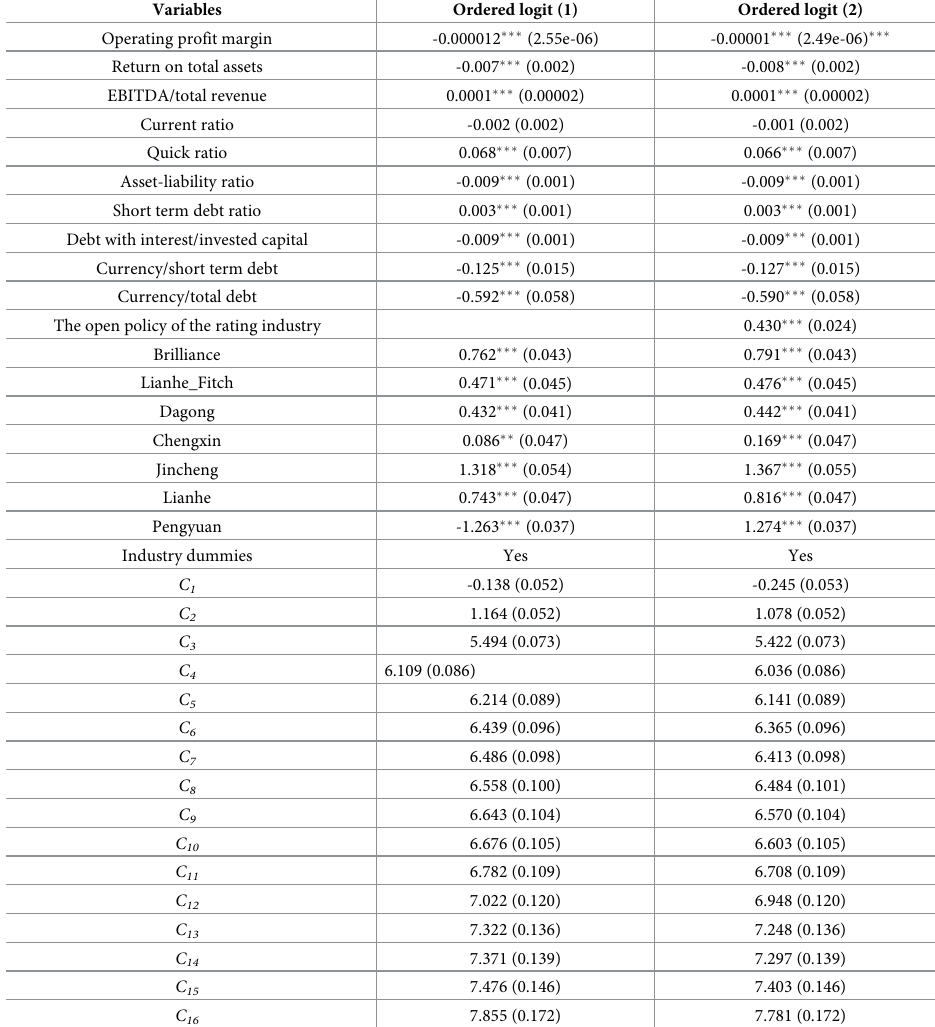
Table 7. Regression results of corporate bond